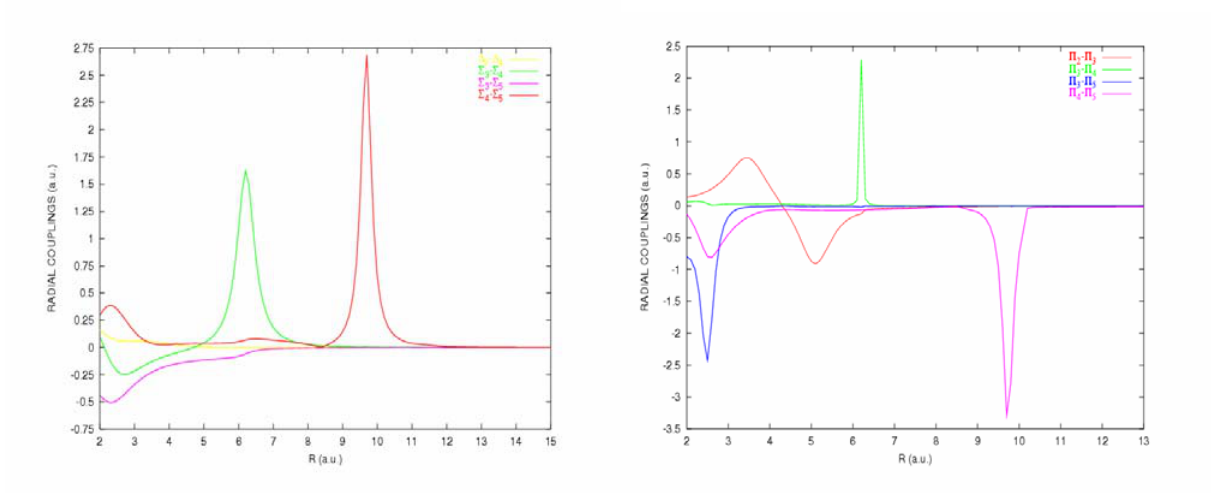
The rotational matrix elements iL ψψ between states of angular moment ∆Λ =±1 have been LyK calculated directly from the quadrupole moment tensor. The coupling matrix elements for the triplet manifold are displayed in Figure 5. Rotational couplings between Σ - Π and Π - ∆ are zero at long range for states corresponding to different configurations, as shown for example for the coupling between 3 Σ + {S 3+ (3s3p 3 ) 3 P° + H +1 S} and 3 Π {S 2+ (3s3p 3 ) 3 D° + H +1 S} levels. The couplings corresponding to the same configuration reach the asymptotical value 1.0 a.u., as shown for the 3 Σ + - 3 Π couplings corresponding to the {S 3+ (3s 2 3p) 2 P° + H(1s) 2 S} and the {S 2+ (3s3p 3 ) 3 P + H +1 S} configurations, as